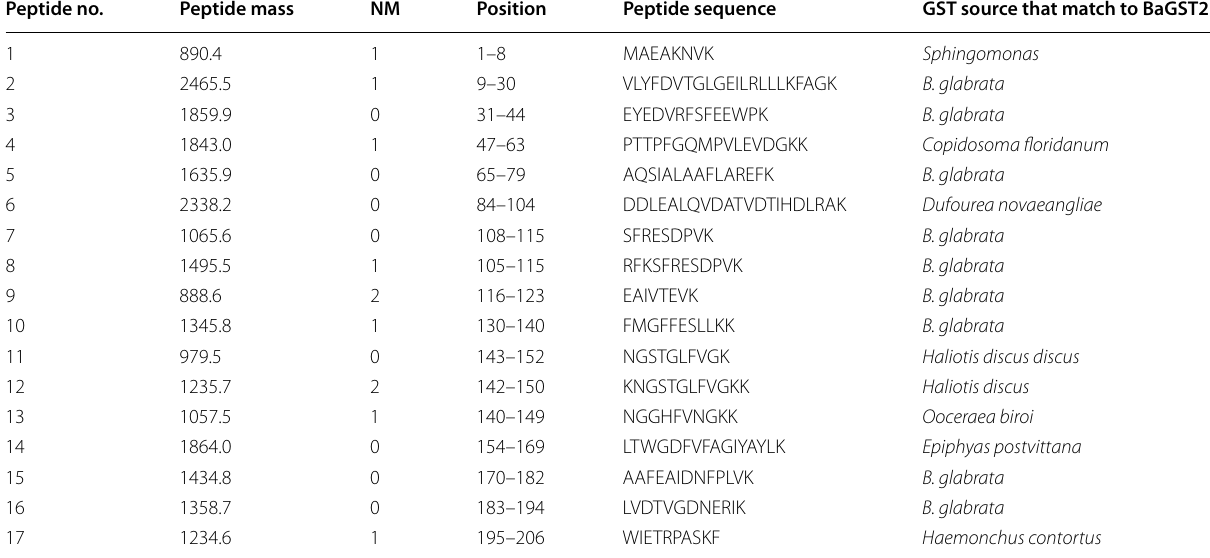
Table 5 BaGST2 peptides masses measured by HPLC. Peptide masses and their amino acid sequences were obtained by theoretical Lys‑C digestion of different GSTs. The amino acid sequences of peptide nos. 3, 9, and 15 were determined using a gas‑phase sequencer. The values were rounded to the nearest tenths Peptide